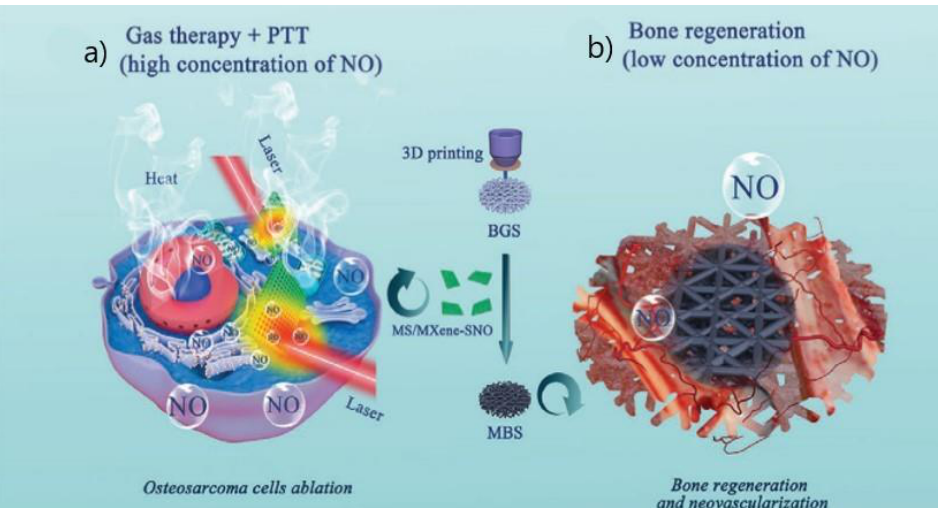
Figure 7. Schematic illustration of the multifunctional therapeutic platform. ( a ) NO gas release triggered by NIR radiation combined with PTT destroys osteosarcoma cells while ( b ) slow release of NO post-PTT stimulates bone regeneration. Reproduced with permission from [99] © 2020 WILEY- VCH Verlag GmbH & Co. KGaA, Weinheim.